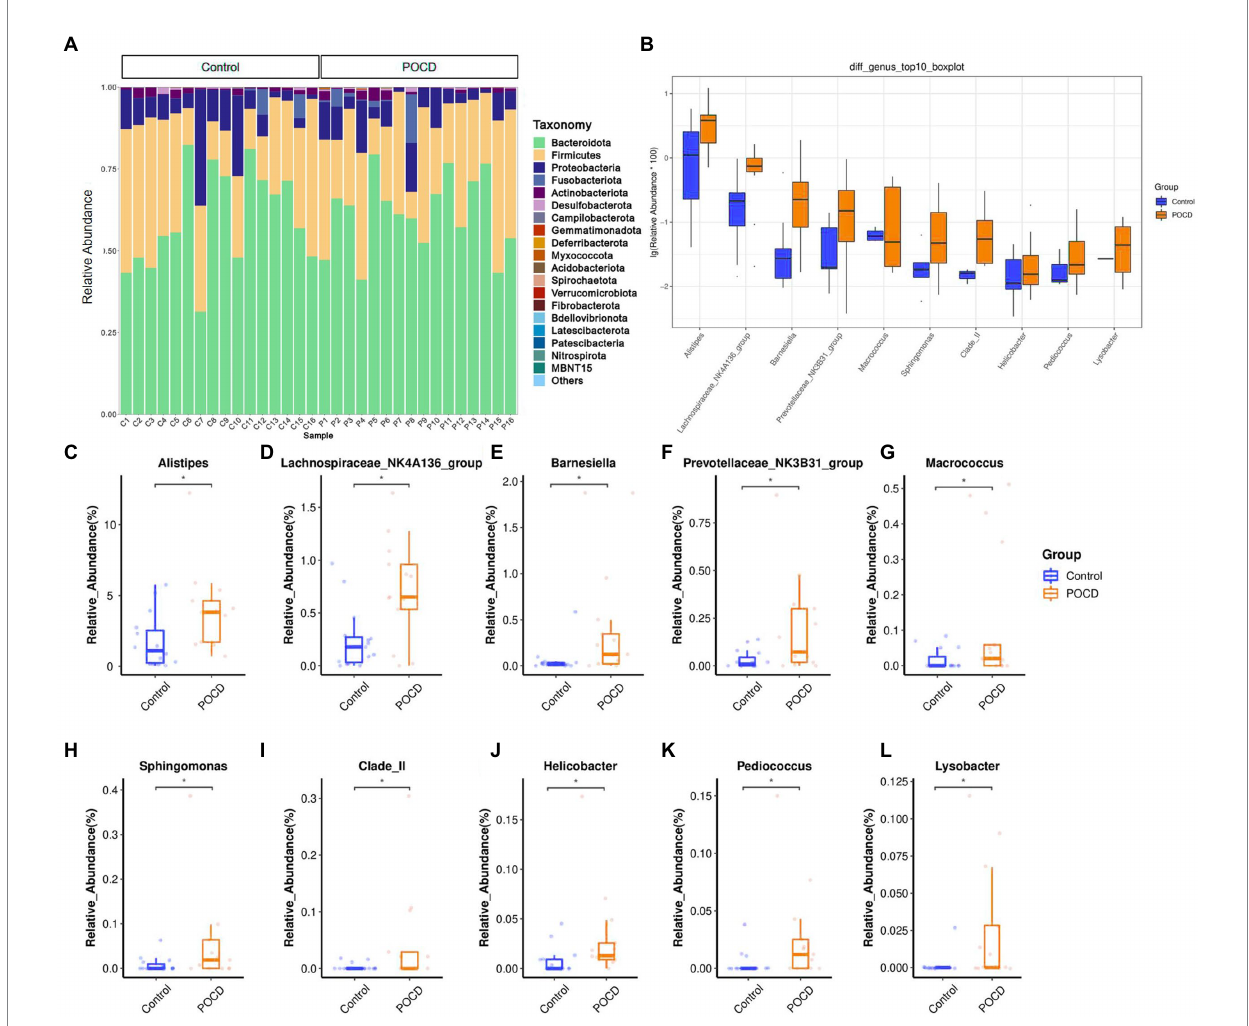
FIGURE1 Comparisons of relative abundance of gut microbiota. (A) Histogram results for the top 20 in order of relative abundance at phylum level, which shows Bacteroidota, Firmicutes, Proteobacteria etc. contribute the main components of gut microbiota, (B) Comparisons between the two groups using Wilcoxon rank sum test, significant differences in relative abundance were observed in 20 genus (* p < 0.05), and (C – L) Relative abundance of differential genera bacterium, analyzed by two-tailed Wilcoxon rank-sum test, data represent the means ± SEM, n = 16 in each group, * p < 0.05 compared with Control